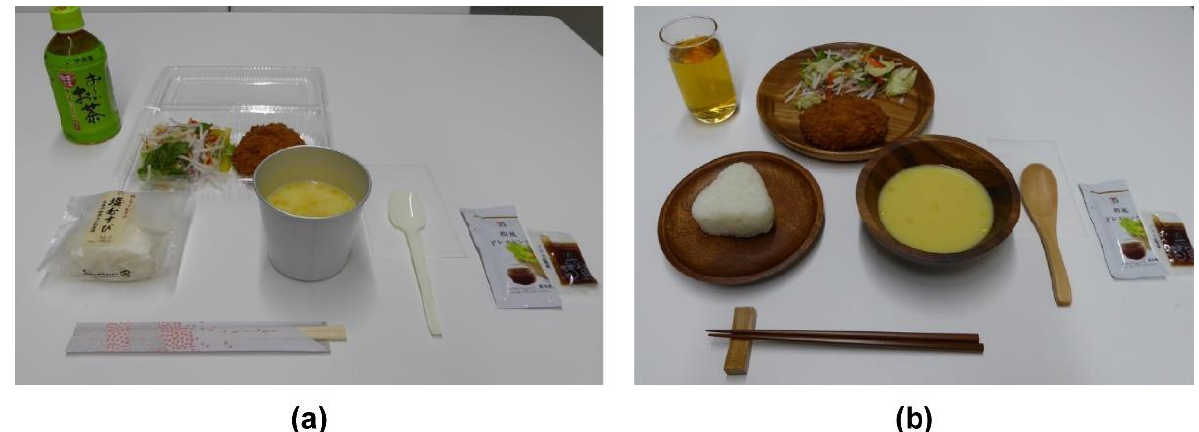
Figure 1. The meals used for each experimental condition. ( a ) Plastic tableware condition; ( b ) natural wooden tableware condition.